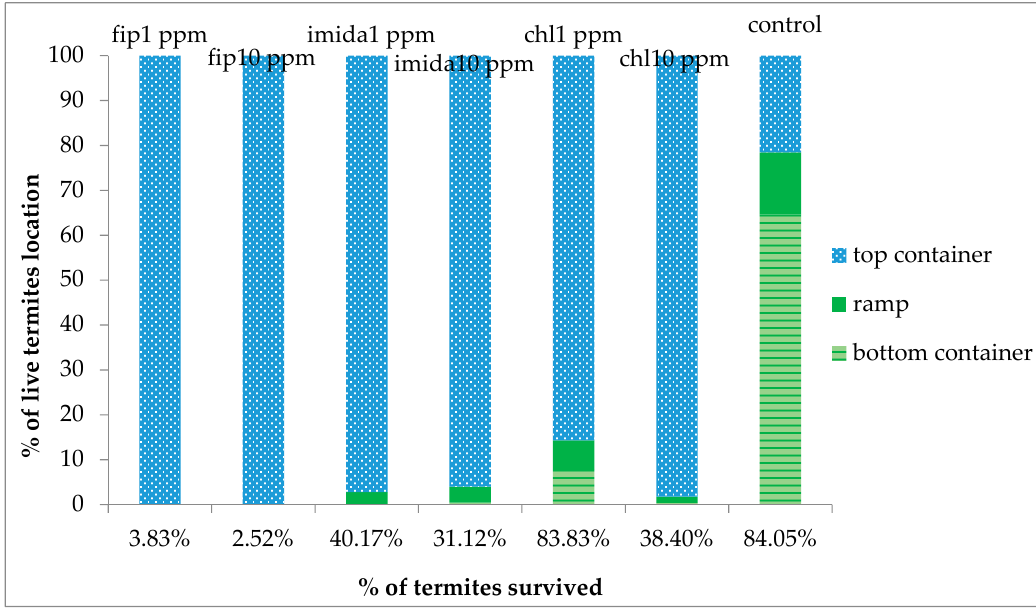
Figure 5. Percentage of live termites located among the three sites (top foraging substrate, ramp and bottom foraging substrate) after one month (12 days for fip10 ppm) of treatment. Y-axis is the total percentage of live termites retrieved after one month of treatment.